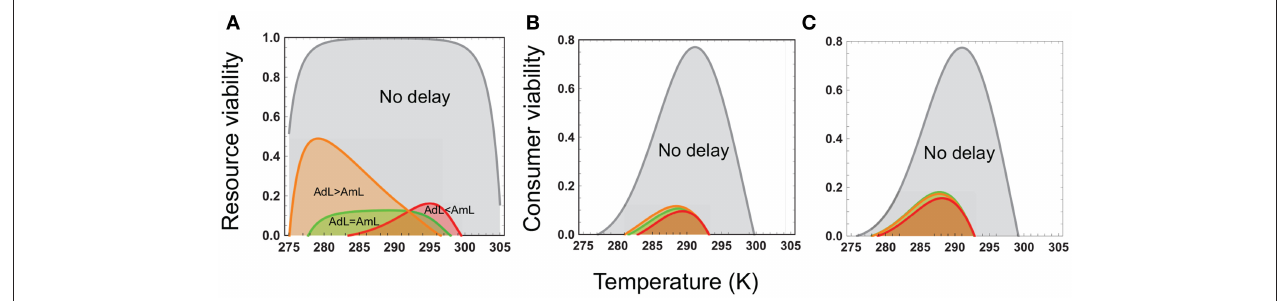
FIGURE 2 | Resource and consumer species’ viabilities as a function of temperature. In each panel, the gray curve depicts the temperature range over which each species has a positive abundance in the absence of developmental delays (Equations 7, 8), and the orange, green, and red curves, the temperature range for viability in the presence of delays (Equations 9, 10). In (A) , the green, orange, and red curves represent, respectively, the resource species viability when the consumer’s − A m = 0), mortality has greater temperature sensitivity than maturation temperature sensitivities of maturation ( A m L ) and mortality ( A d ) are the same ( k 1 = A d L L L ( k 1 = 8,000), and vice versa ( k 1 = − 8,000). In (B) , the green, orange, and red curves represent, respectively, the consumer species’ viability when the resource and consumer species’ temperature sensitivities of maturation are the same ( k 2 = A m J − A m L = 0), resource’s maturation has lower temperature sensitivity than consumer’s ( k 2 = − 4,000) and vice versa ( k 2 = 4,000). In (C) , the curves depict depicts consumer viability the consumer species’ viability when the resource and − A d = 0), resource’s mortality has greater temperature sensitivity than consumer species’ temperature sensitivities of mortality are the same ( k 3 = A d J L